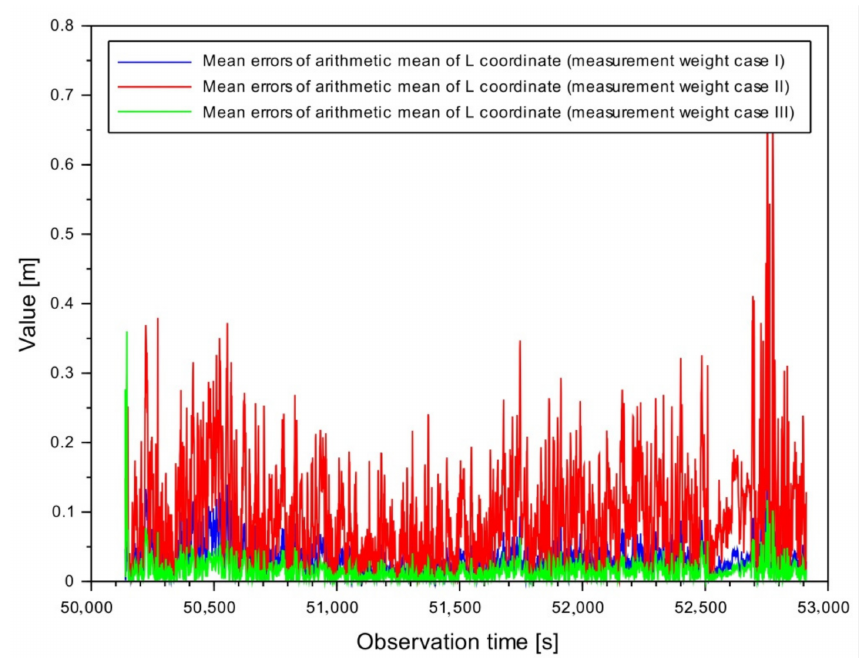
Figure 11. Mean errors of the arithmetic mean of L resultant